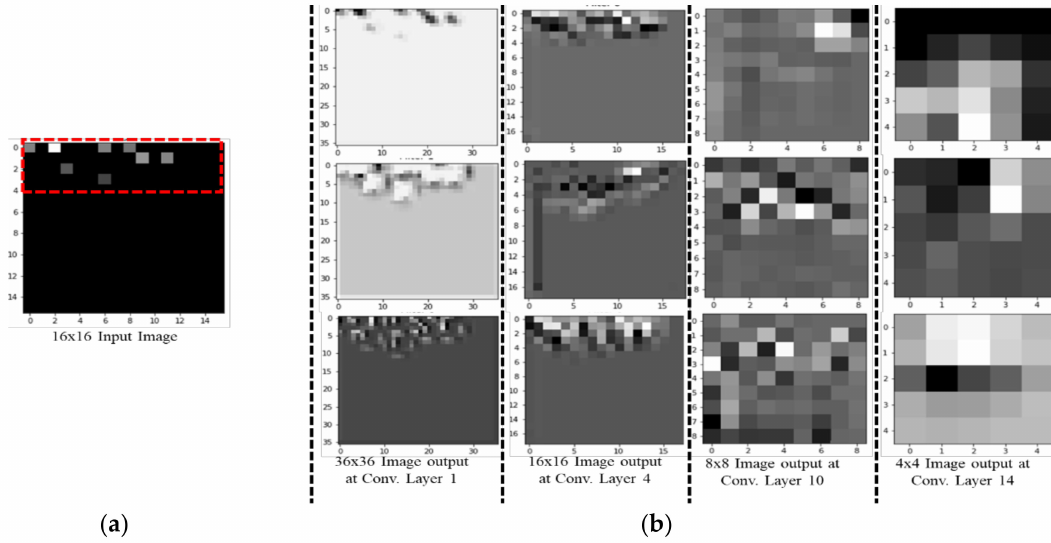
Figure 14. Image outputs for MobileNet v2. ( a ) Input Image. ( b ) Output image with di ff erent convolution